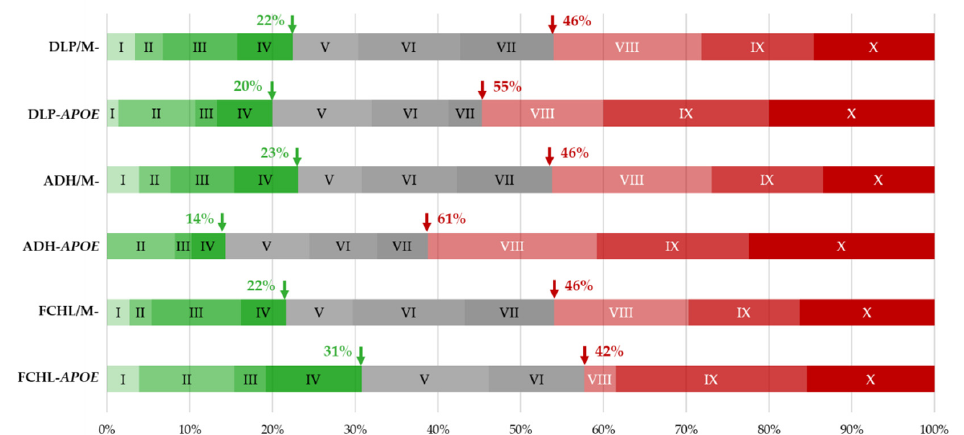
Figure 2 : Distribution of the 12-SNP weighted polygenic risk score (wPRS) within the deciles of the Whitehall II control cohort [7] . Comparison between dyslipidemic (DLP=ADH/FCHL), ADH, or FCHL probands carrying an APOE rare variant or without any ADH/FCHL causative mutation (/M-). Green arrows indicate the percentage of probands with a low wPRS and a probability of monogenic DLP that gradually increases under decile V. Red arrows indicate the percentage of probands with a wPRS in the top three deciles with a high probability of polygenic DLP.